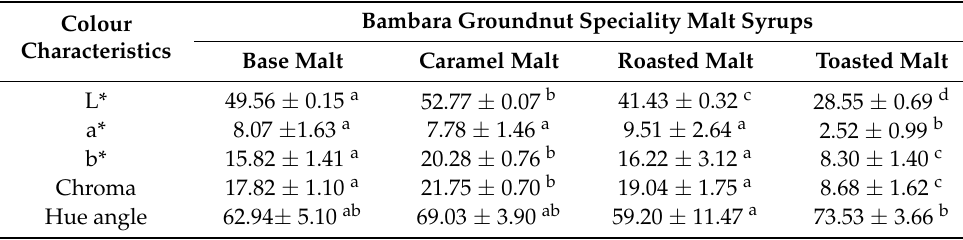
Table 2. CIE L*a*b*, chroma, and hue for the Bambara groundnut speciality malt syrups 1 . Colour